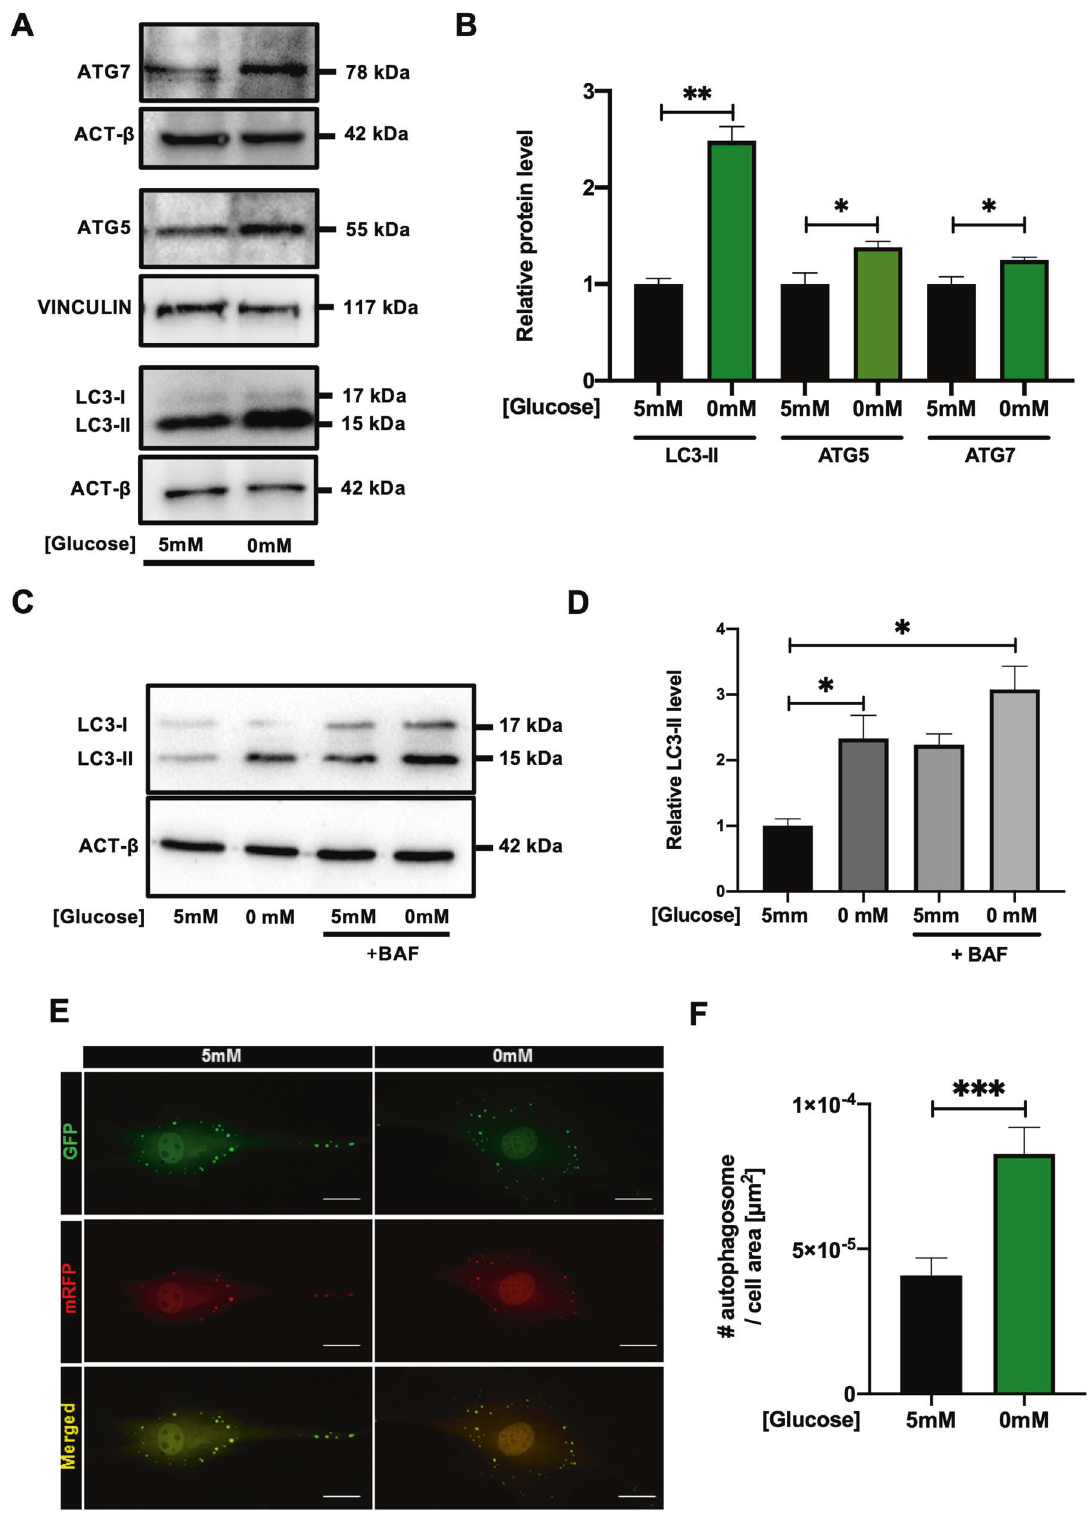
Fig. 2 Autophagy is activated in CSCs in response to nutrient deprivation. Representative WB panels (A) of LC3-II, ATG5 and ATG7 protein levels, and corresponding densitometric analysis (B) after 4 hours of nutrient deprivation (0.1% FBS, 0 mM glucose) ( n = 3). Representative panels (C) and relative quanti fi cation of LC3-II (D) with or without concomitant treatment for 2 hours with 100 nM ba fi lomycin A1 (BAF) are also shown ( n = 3). E Representative fl uorescence microscopy images of Ad-mRFP-GFP-LC3 transduced cells, exposed for 4 hours either to nutrient deprivation or control media (5 mM glucose), with corresponding quanti fi cation of the number of mRFP + /GFP + autophagosomes per cell surface area (F) . Scale bars = 20 µm. * P <0.05, ** P <0.01, *** P <0.001. Cell Death Discovery (2022)